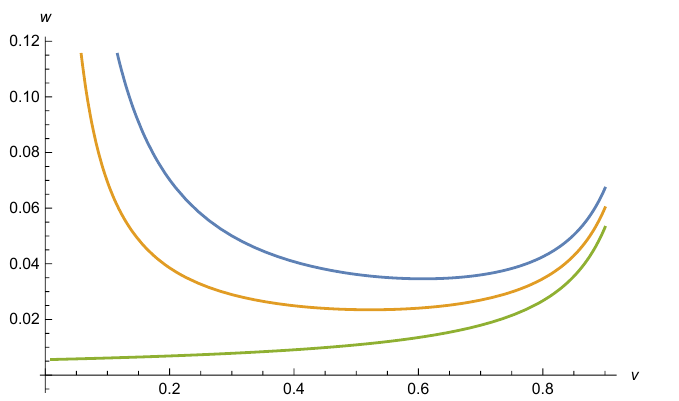
Figure 1. Relation between v and w for three values N = 12 (upper curve), N = 4 (middle curve), and N = − 4 (lower